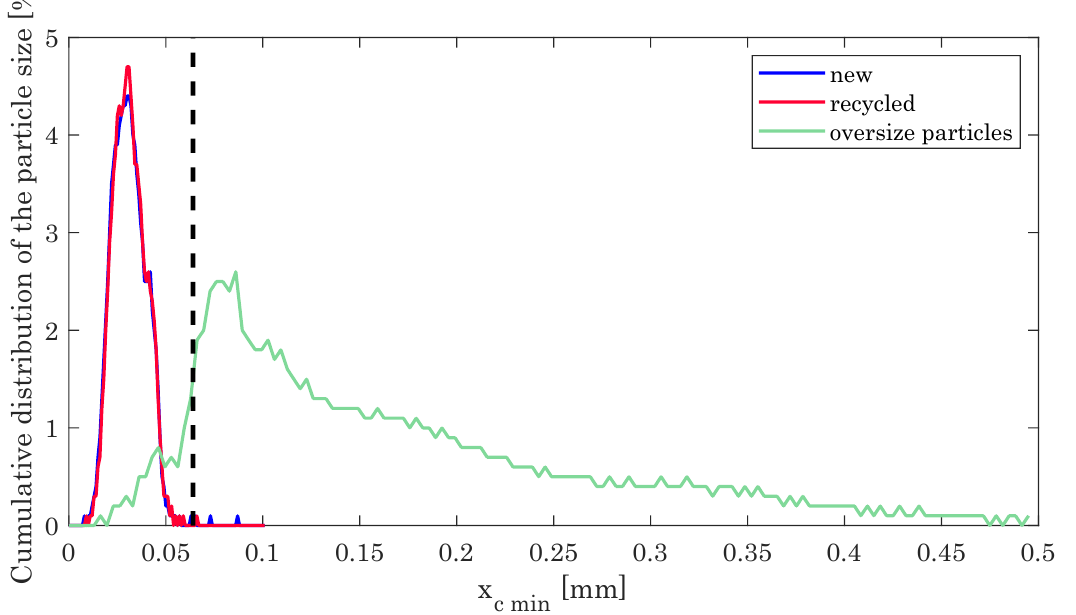
Figure 3. Powder distribution of new powder, recycled powder and the oversize particles.